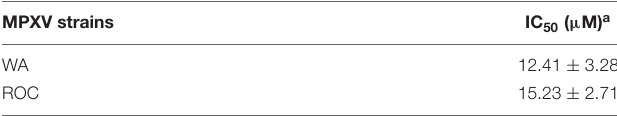
TABLE 2 | Inhibitory effect of resveratrol on MPXV replication in HeLa